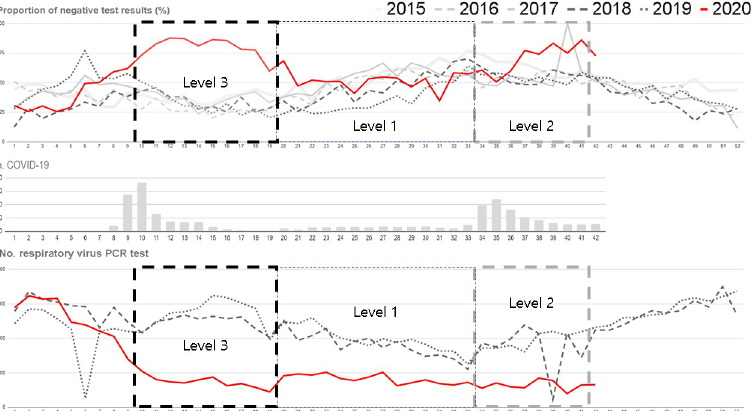
Fig 1. Weekly proportion of negative respiratory virus PCR test results (upper graph), weekly number of COVID- 19 patients (middle graph), and weekly number of respiratory virus PCR tests (lower graph) in South Korea between the 1st week of 2015 and the 42nd week of 2020. PCR, Polymerase chain reaction; COVID-19, Coronavirus disease 2019.